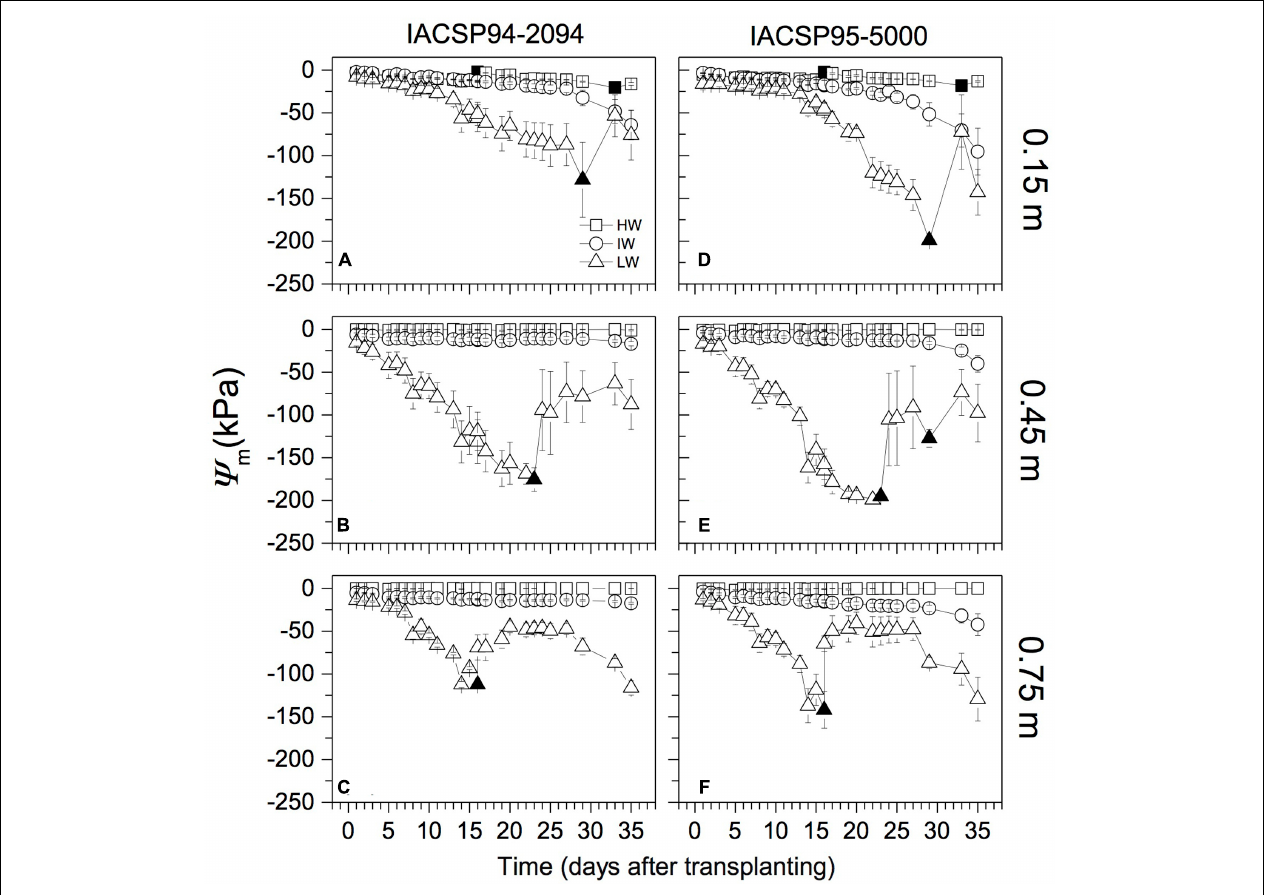
FIGURE 1 | Water matric potential ( (cid:57) m ) along the soil profile under three water regimes: high (HW), intermediate (IW), and low (LW) water availability. Two sugarcane varieties were grown (IACSP94-2094 in A–C , and IACSP95-5000 in D–F ) and each symbol is the mean value ( ± SD) of three replications, with exception of data for LW at (C) ( n = 2). Closed symbols indicate